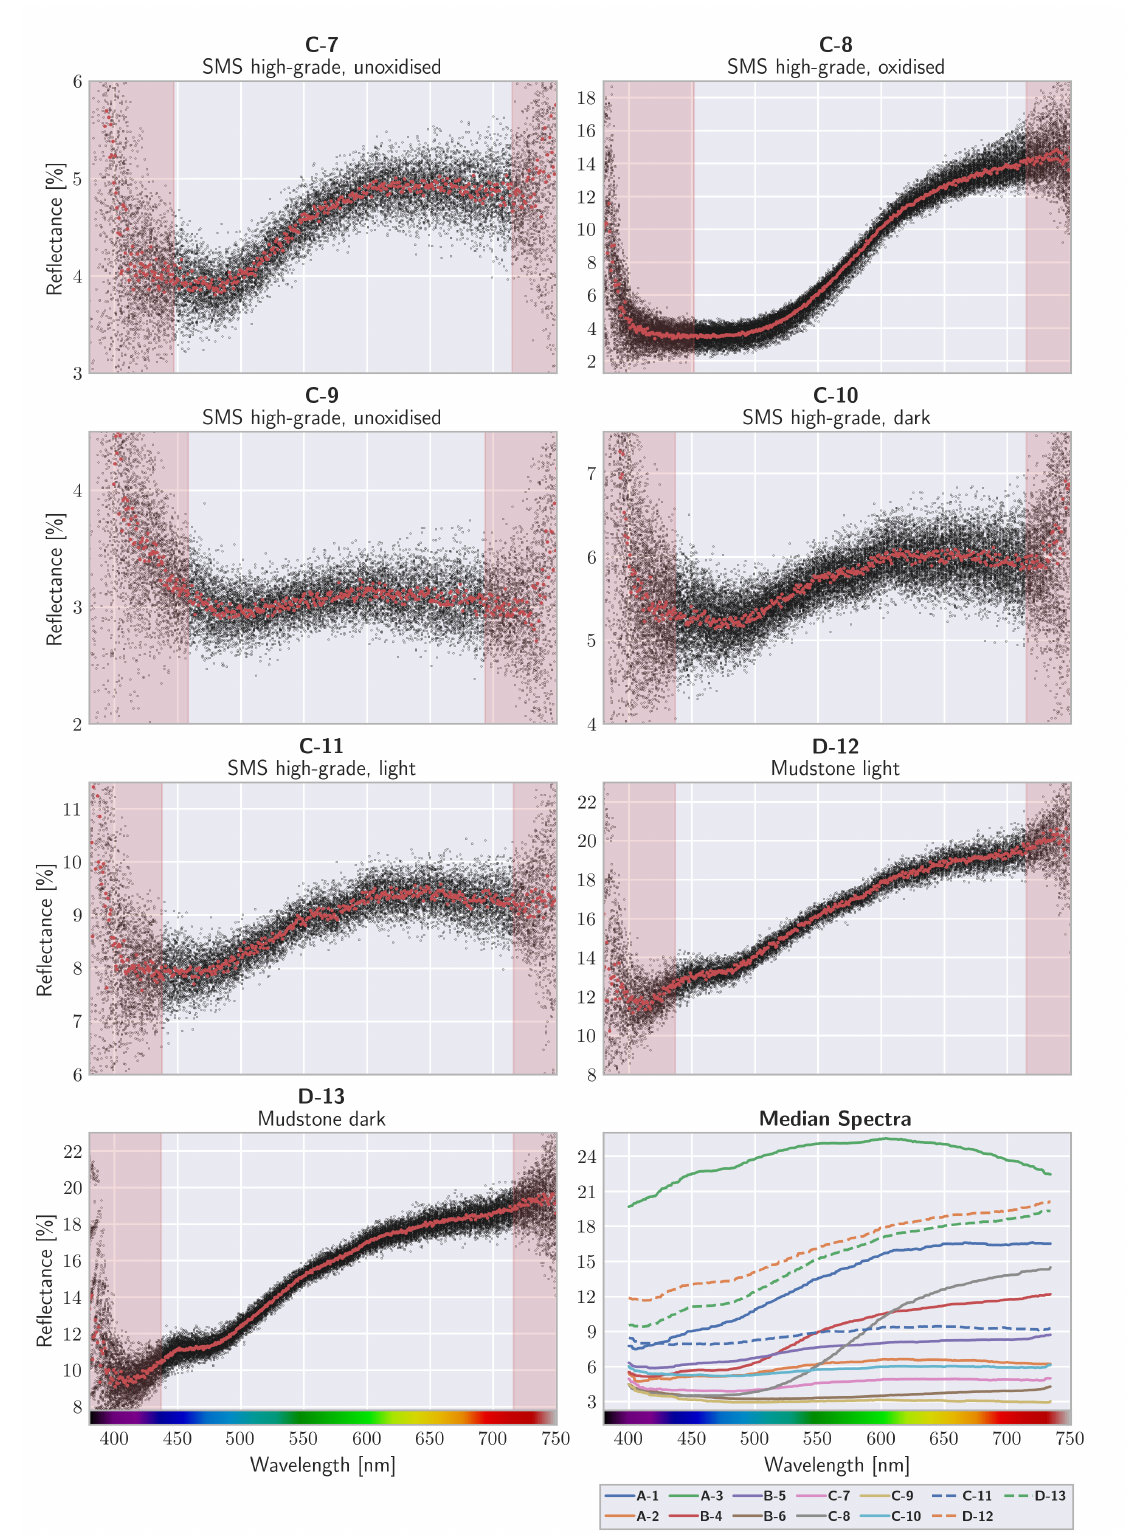
Figure 8. Calculated reflectance from the marked areas. The red points are the medians across wavelengths, and the points in black are calculated reflectances for individual pixels centred on the median. The regions in red are regions where the signal-to-noise ratio was below the threshold. In the last plot, a comparison between a selection of median spectra is shown. Note that the x-axes are shared across the plots and the y-axes have individual scales and